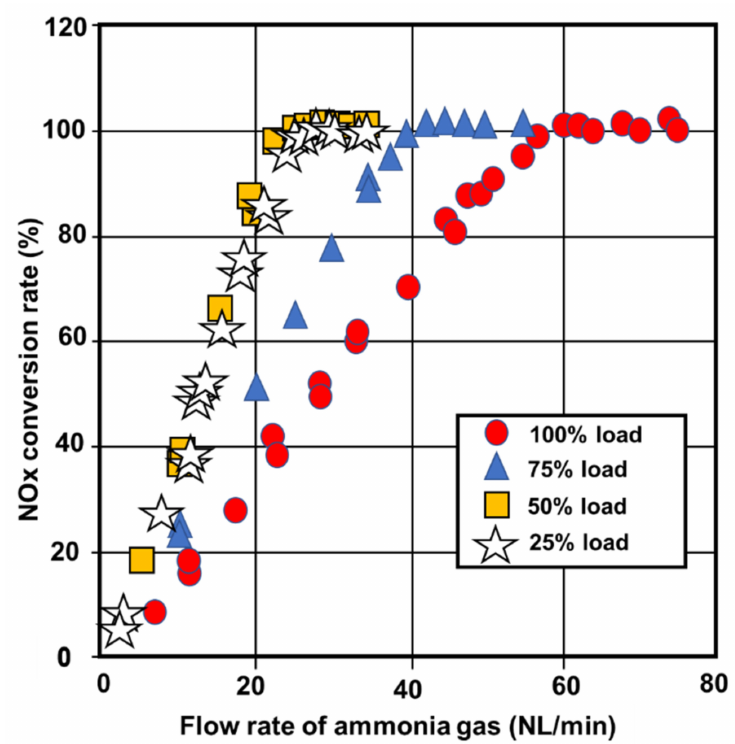
Figure 37. NOx conversion rate values against ammonia gas flowrates